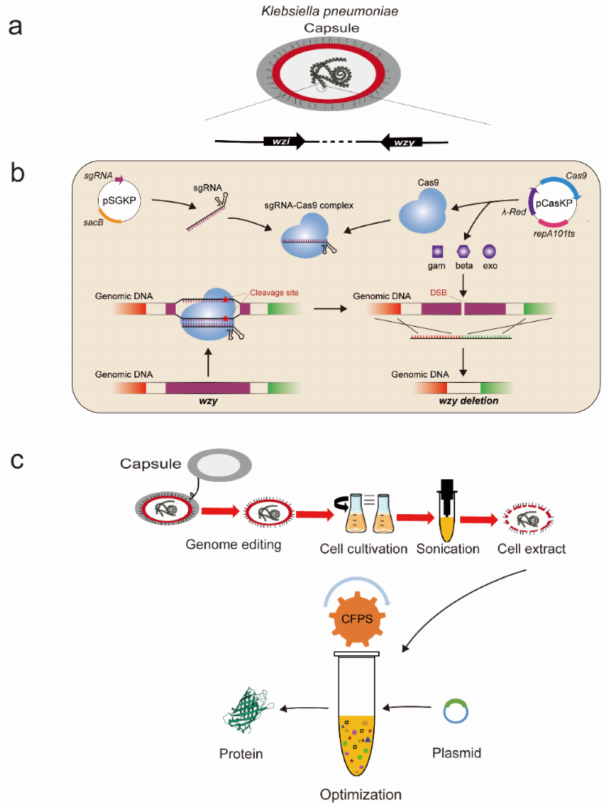
Figure 1. Development of a K. pneumoniae -based CFPS system. ( a ) The genes ( wzi and wzy ) from